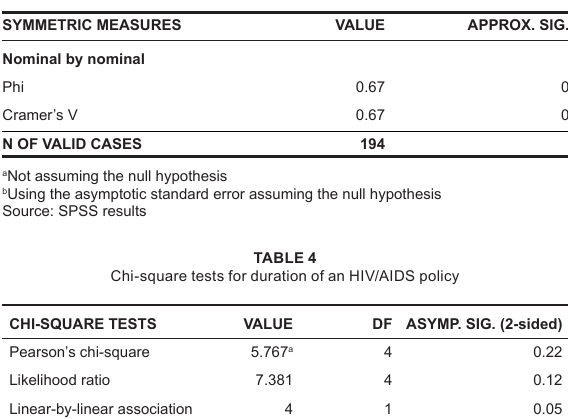
TABLE 3 Symmetric measures of the existence of an HIV/AIDS policy